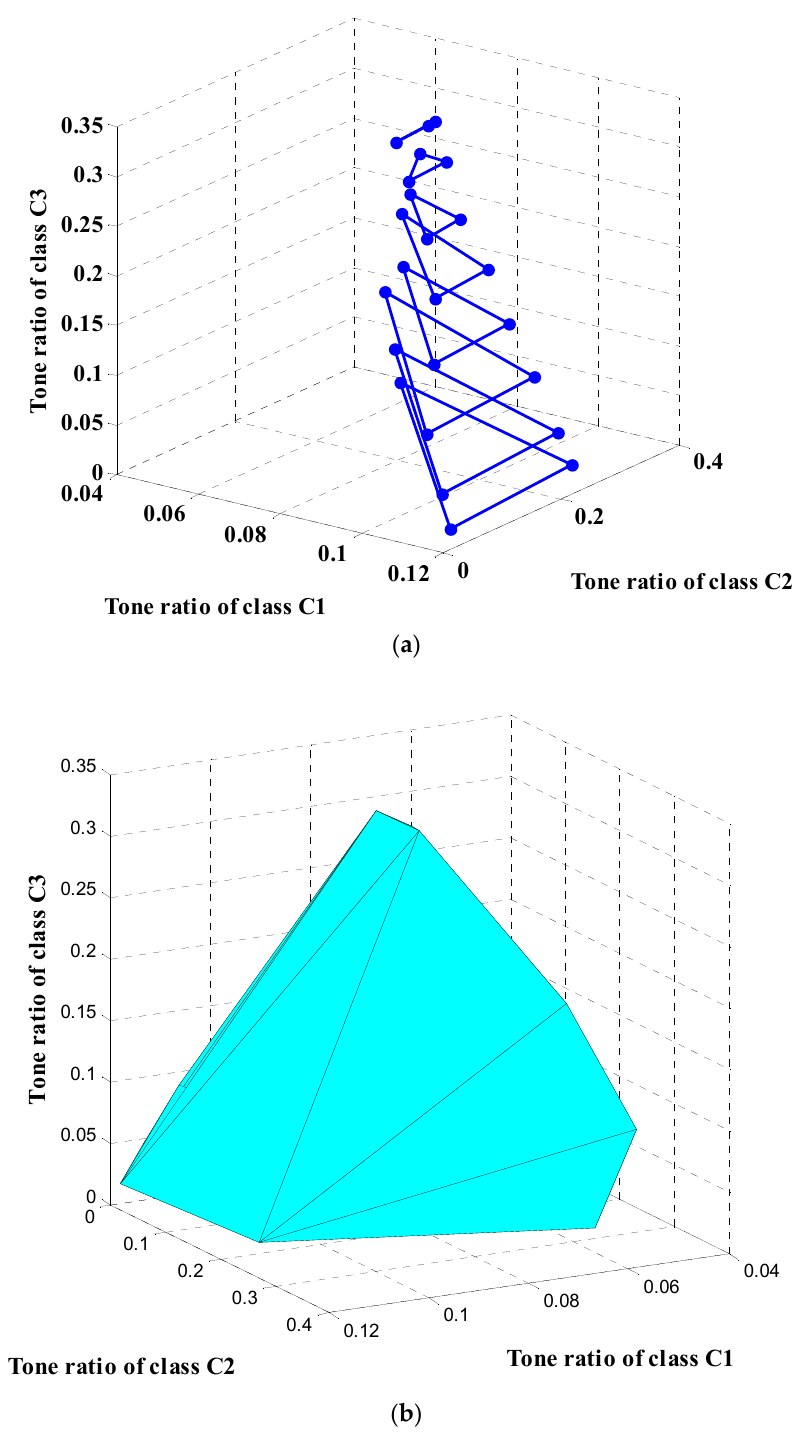
Figure 6. Solution domain D in the 3D space: ( a ) section contours, and ( b ) constructed solution